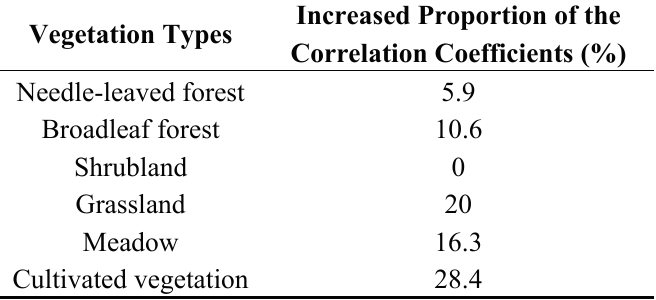
Table 3. The improvements of correlation coefficients for SPEI opt